Question: Summarize what this figure shows in one sentence.
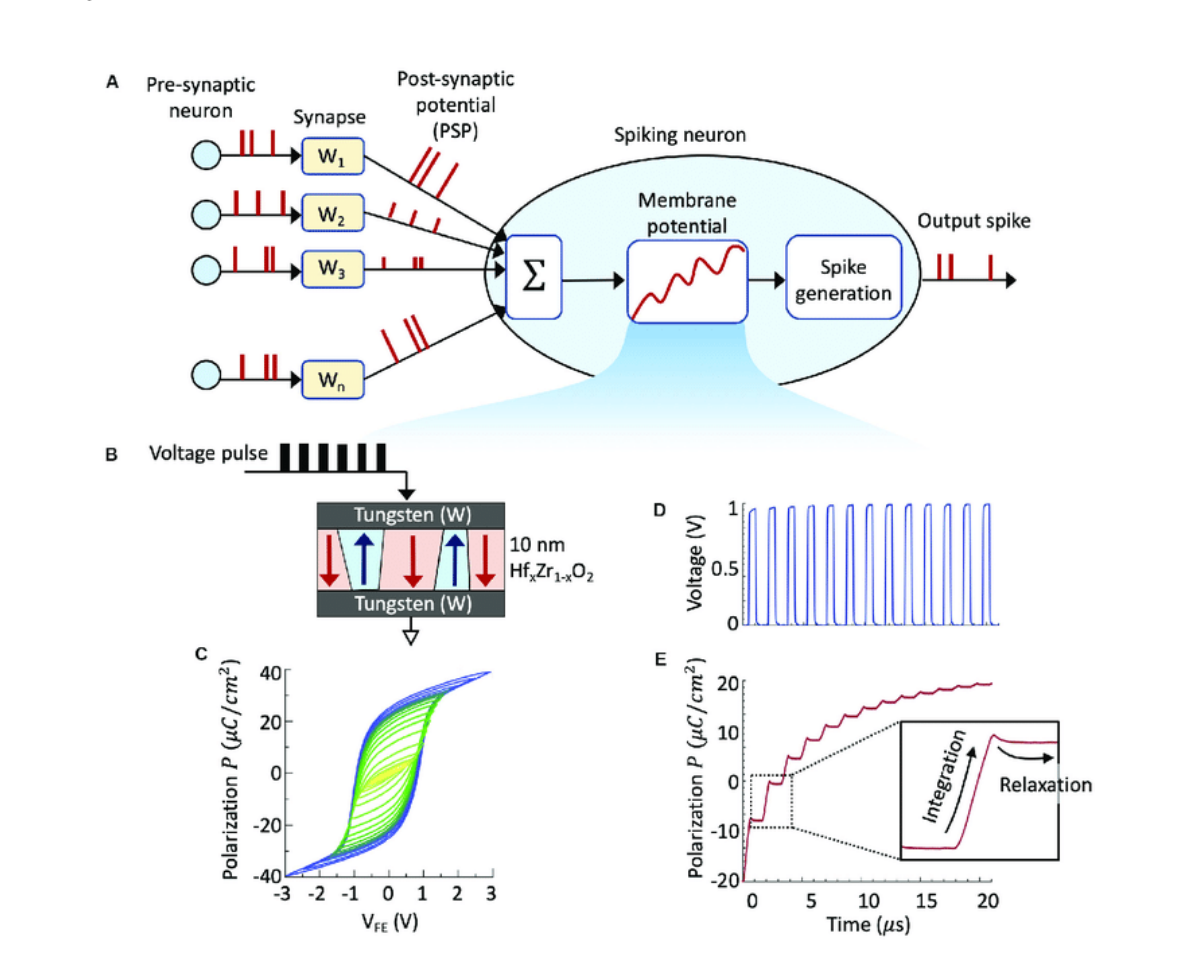
Answer: (A) Spiking Neural Network: This model represents a neuron (spiking) connected by adjustable synapses (plastic) in an array. The core of the neuron is its membrane, modelled by a special state variable (ferroelectric polarization). (B) Ferroelectric Capacitor: This tiny device (MFM capacitor) uses a thin film (Hf x Zr 1-x O 2) sandwiched between metal plates (W) to study how voltage affects polarization switching. (C) Polarization vs. Electric Field: This graph shows how the material’s polarization (P) changes with applied voltage (E). The loops indicate multiple internal regions within the film. (D-E) Mimicking Neurons: Short voltage pulses can be used to study how polarization changes over time. This behaviour resembles how a real neuron’s membrane integrates and relaxes with electrical signals. Image Source [21]